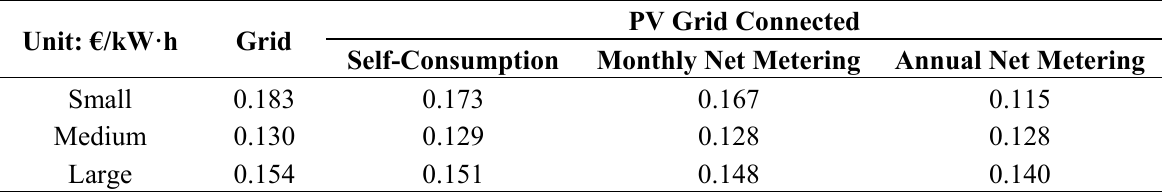
Table 8. Cost of energy